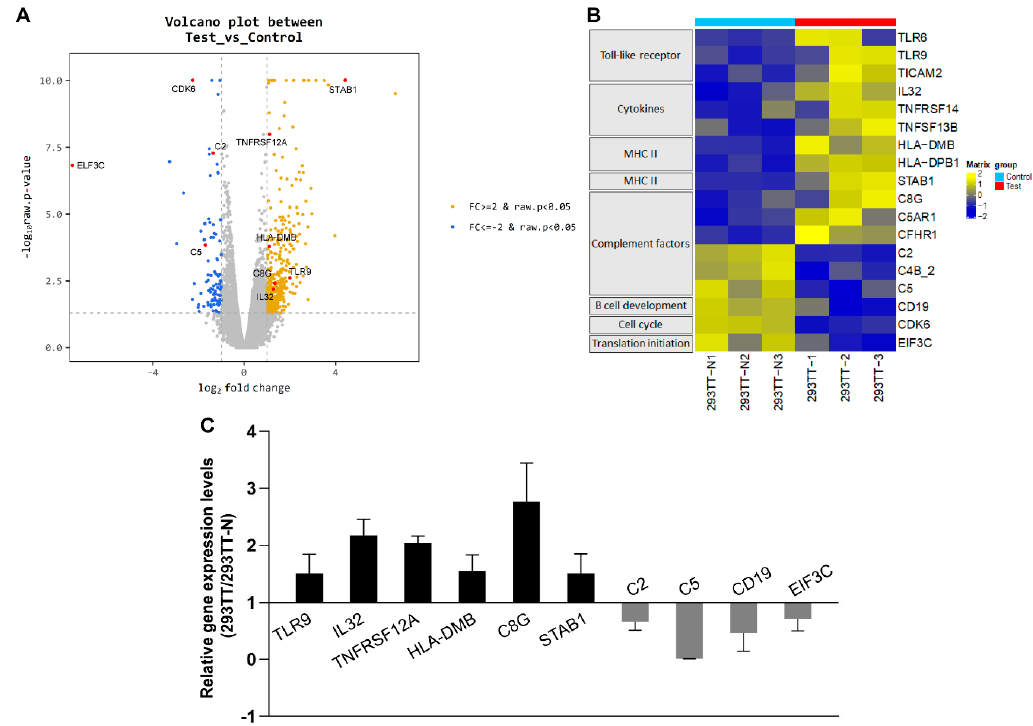
Figure 5. Transcriptome profiles of host immune-response genes. ( A ) Volcano plot shows the fold change (log 2 transformed) and variance for human gene transcripts in AcHERV env -CMV-GFP-infected 293TT cells relative to uninfected controls. Differentially expressed transcripts are highlighted in orange. ( B ) Heatmap depicting relative change in the expression of host immune-response genes. ( C ) qRT-PCR analysis of the indicated genes in AcHERV env -CMV-GFP-infected 293TT cells and uninfected controls verifies the RNA-seq data. mRNA levels of indicated genes in 293TT and 293TT-N were normalized to GAPDH levels. Gene expression levels of 293TT relative to 293TT-N are shown as the means ± s.e.m. of six independent replicates.